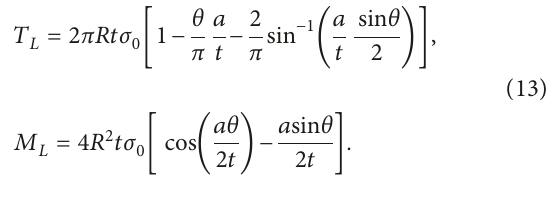
0.2, θ / π 0.01, (cid:31) (cid:31)